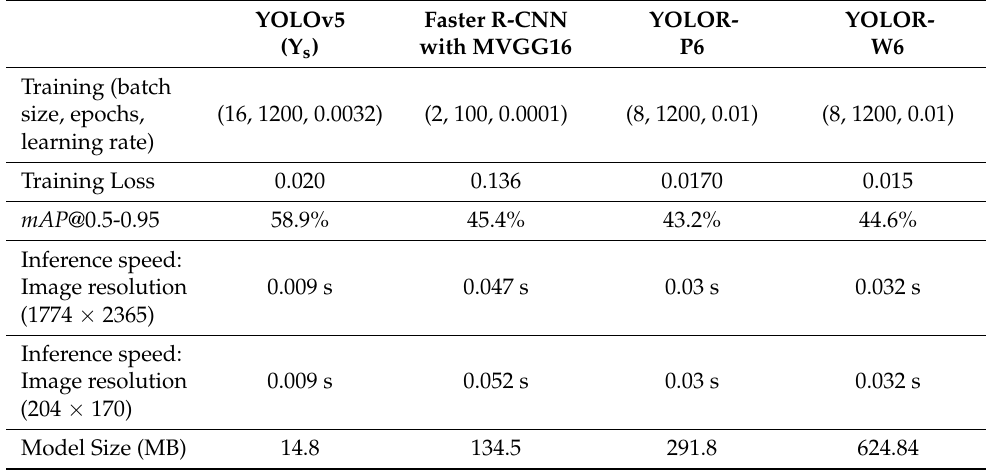
Table 4. Comparison of YOLOv5 small, Faster R-CNN with MVGG16, and YOLOR models.